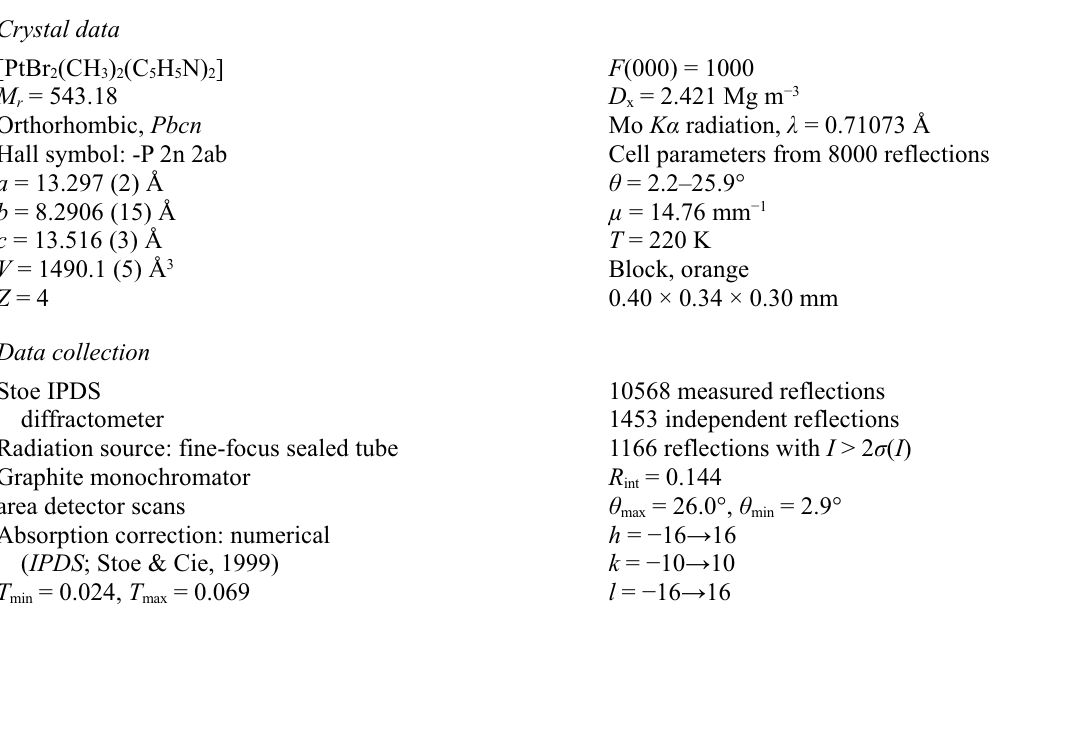
Figure 1 A view of the title complex with displacement ellipsoids drawn at the 30% probability level. H atoms are shown as small spheres of arbitrary radii. [Symmetry code: (i) - x , y , - z + 3/2 z ].